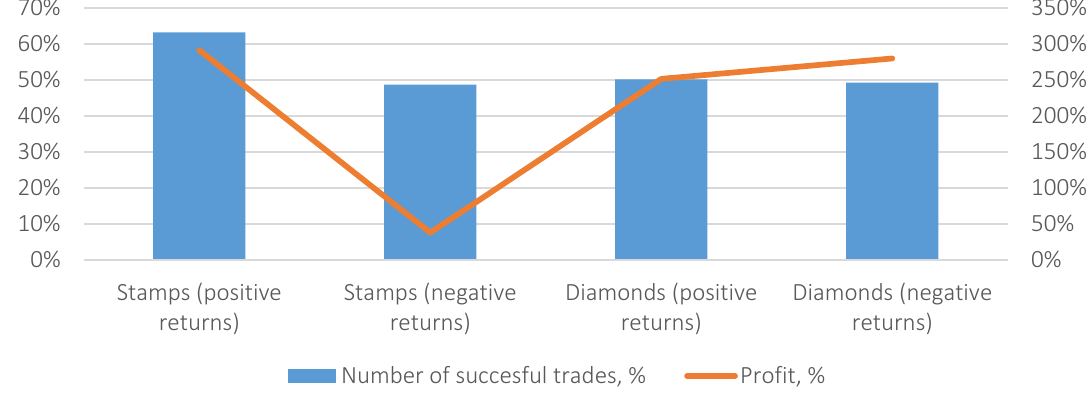
Figure 2. Visual interpretation of trading simulation results (the case of stamps and